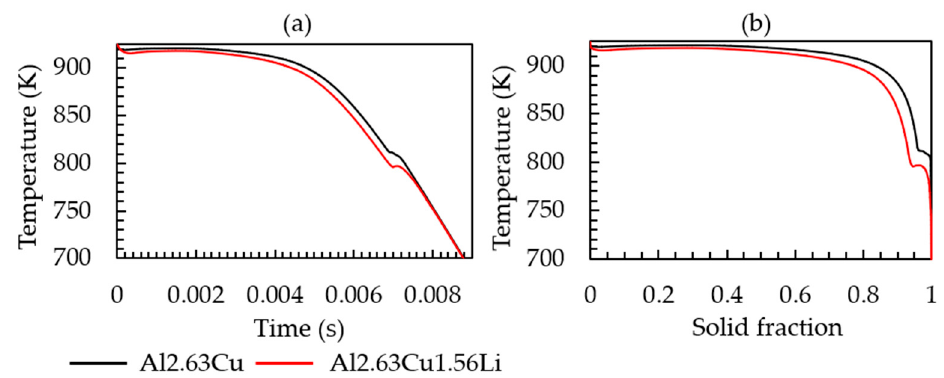
Figure 2. ( a ) Time-temperature cooling curve; ( b ) solid fraction-temperature curve of the Al-2.63Cu and Al-2.63Cu-1.56Li alloys for a constant heat extraction rate of 1.53 × 10 5 Js − 1 cm − 3 .